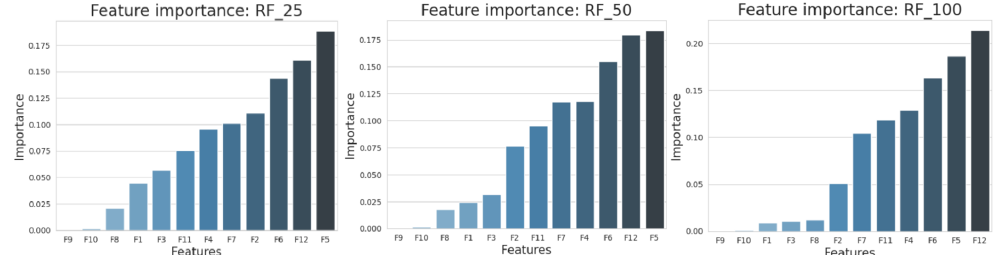
Figure 10. Feature importance in RF_25 ( left ), RF_50 ( middle ) and RF_100 ( right ).